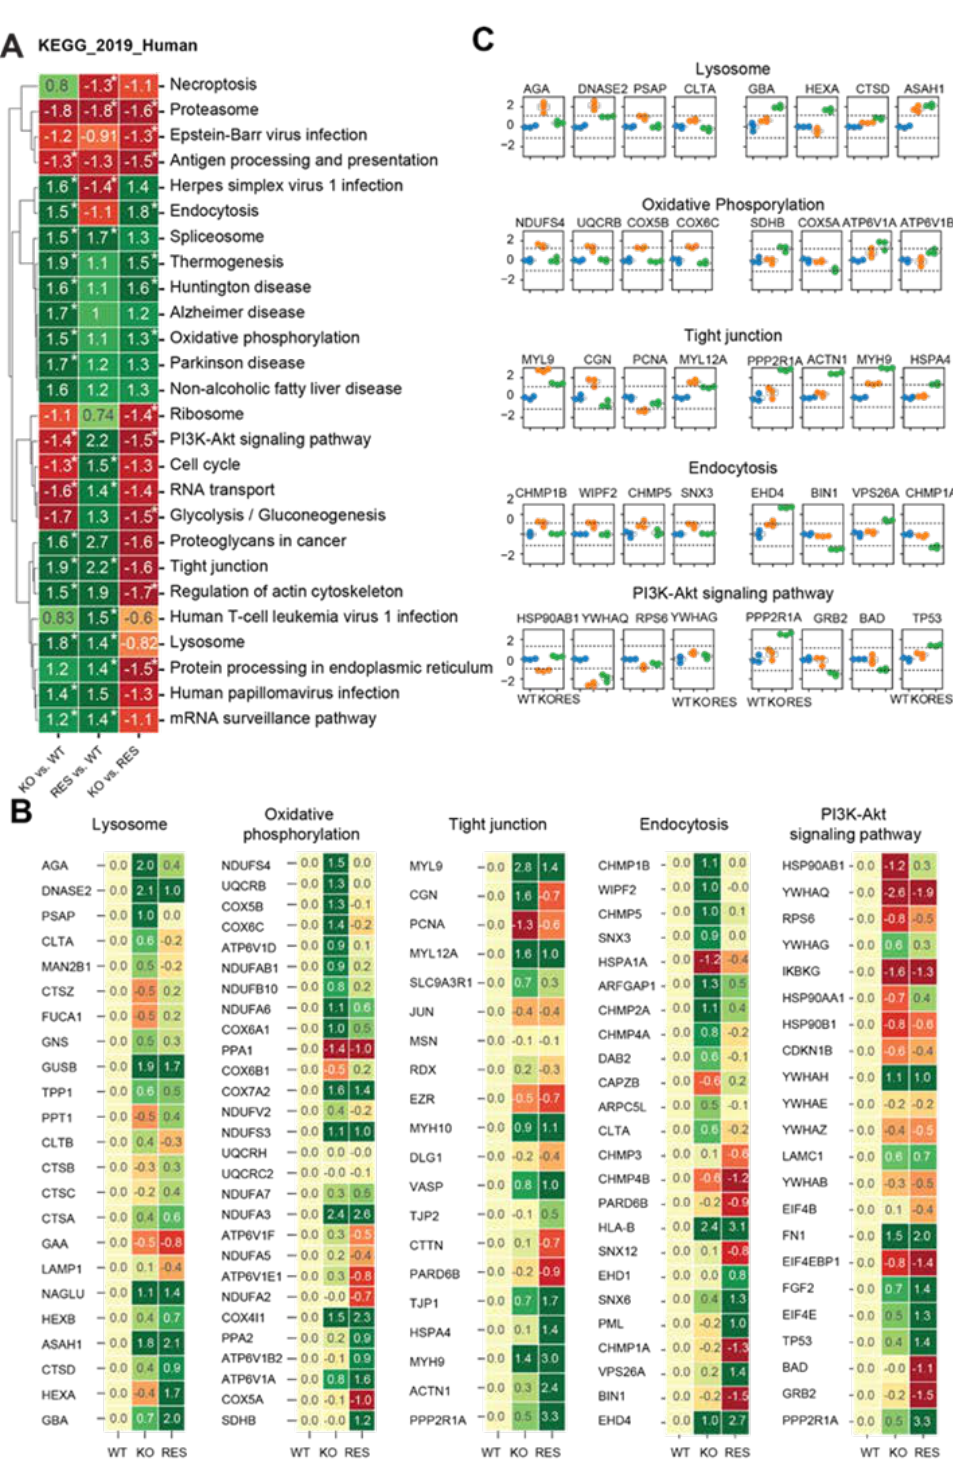
Figure 5. Gene set enrichment analysis using KEGG library to analyze the effects of AGAL rescue. ( A ) Hierarchical clustering of identified up- and downregulated pathways illustrate normalized enrichment scores (nes) from GSEA of the pairwise comparison (KO vs. WT, RES vs. WT, KO vs. RES). An asterisk marks significant changes. ( p value = 0.05, fdr = 0.25). ( B ) Heat maps representing N-fold LFQ mean values of most significant misregulated proteins in 5 representative pathways. For each protein, the log2 mean values were subtracted from WT. Candidates on the top of the heat map represents the strongest rescue and lower the opposite effect. ( C ) Expression of representative proteins from different pathways. Left boxplots represent proteins with strongest rescue effect and right boxplots the opposite effect for KO. blue: WT, orange: KO, green: